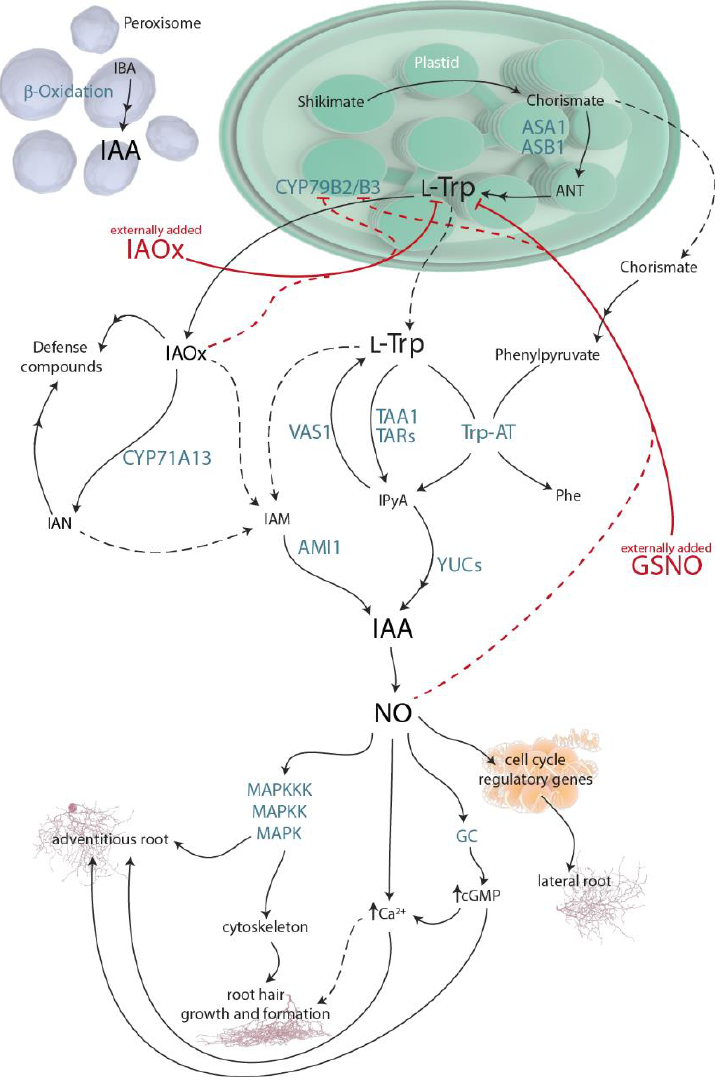
Figure 1. The main pathways for indole-3-acetic acid (IAA) metabolism in plants and the signaling networks involving auxin, NO, and cellular messengers. The main results of this article involving this pathway are represented by plain red lines. Possible implications derived from our results are indicated by dashed red lines. Plain arrow heads indicate inhibition/reduction. Plain black arrows represent described metabolic routes, while dashed black arrows describe not yet clear pathways. Organelles are not drawn to scale. AMIDASE-LIKE PROTEIN 1 (AMI1), anthranilate (ANTAN- THRANILATE SYNTHASE α SUBUNIT 1), (ASA1), ANTHRANILATE SYNTHASE β SUBUNIT 1 (ASB1), cyclic GMP (cGMP), CYTOCHROME P450, family 79, sub-family B, polypeptides 2 and 3 (CYP79B2/B3), guanylate cyclase (GC), indole-3-acetamide(IAM), indole-3-acetonitrile (IAN), indole- 3-acetaldoxime (IAOx), indole-3-butyric acid (IBA), indole-3-pyruvic acid (IPyA), mitogen activated protein kinase signaling (MAPK), phenylalanine (Phe), TRYPTOPHAN AMINOTRANSFERASE OF ARABIDOPSIS 1 (TAA1), TRYPTOPHAN AMINOTRANSFERASE-RELATED PROTEIN (TAR), TRYPTOPHAN AMINOTRANSFERASE (Trp-AT), REVERSALOFSAV3PHENOTYPE 1 (VAS1), and YUCCA flavin-containing monooxygenases